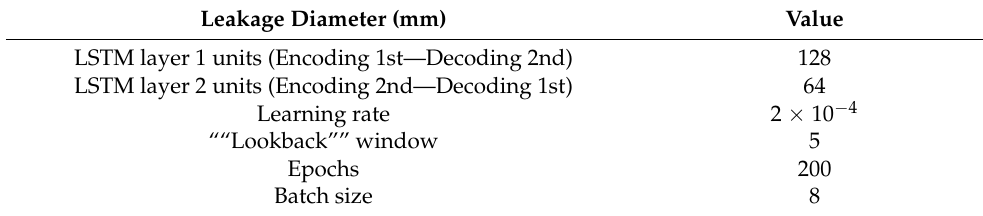
Table 3. Hyperparameter selection—Long Short-Term Memory AutoEncoder.